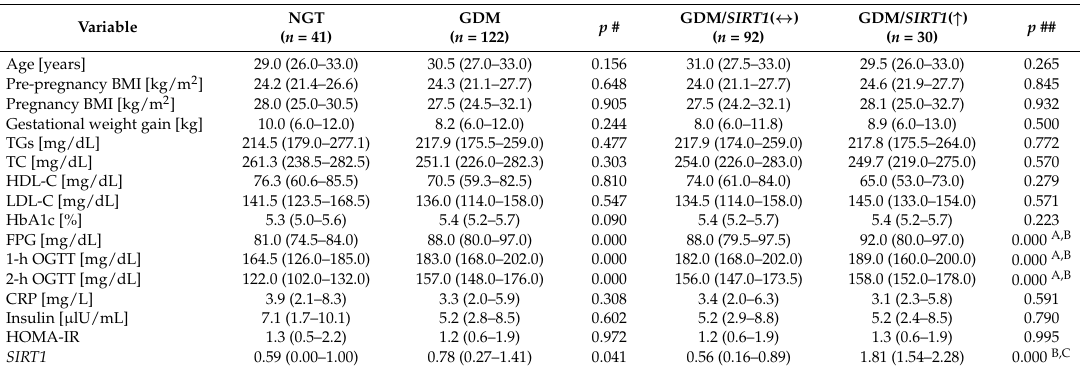
Table 1. Clinical and leukocyte SIRT1 mRNA expression data for different experimental groups.